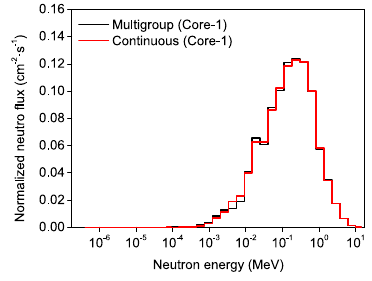
Figure 6. Neutron flux vs energy of core 1